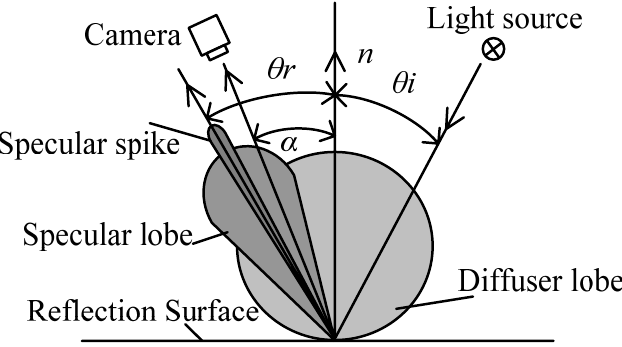
Figure 7. Reflection